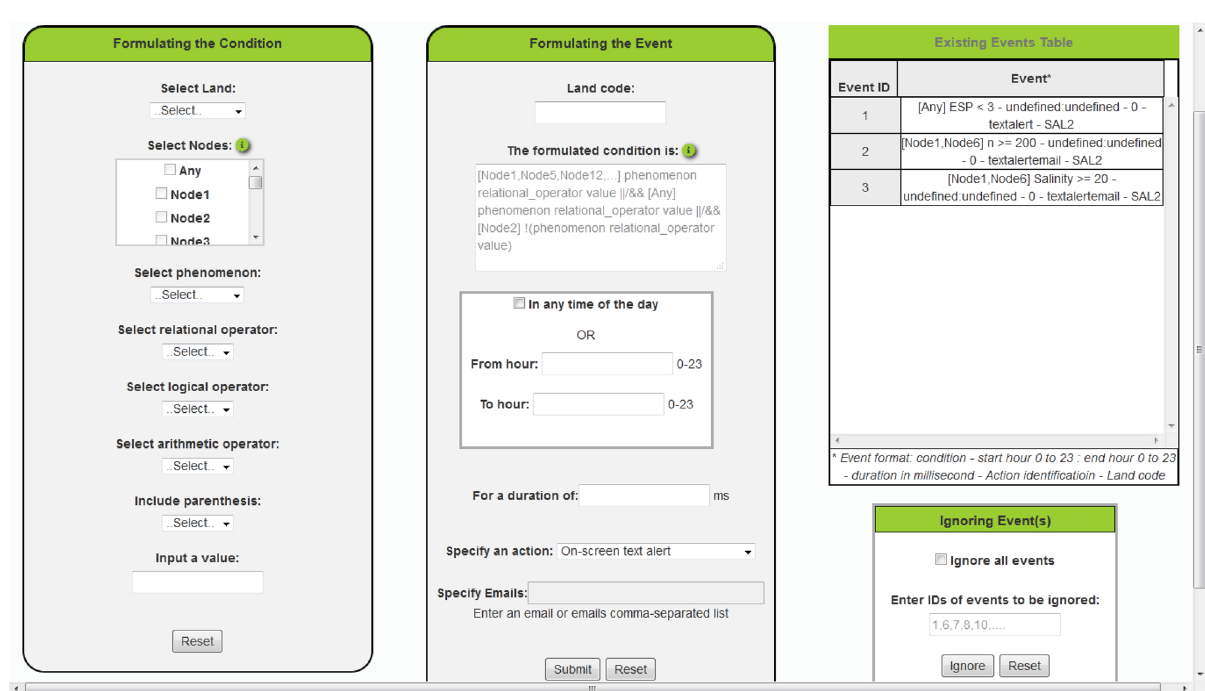
Figure 16. The events and actions settings service